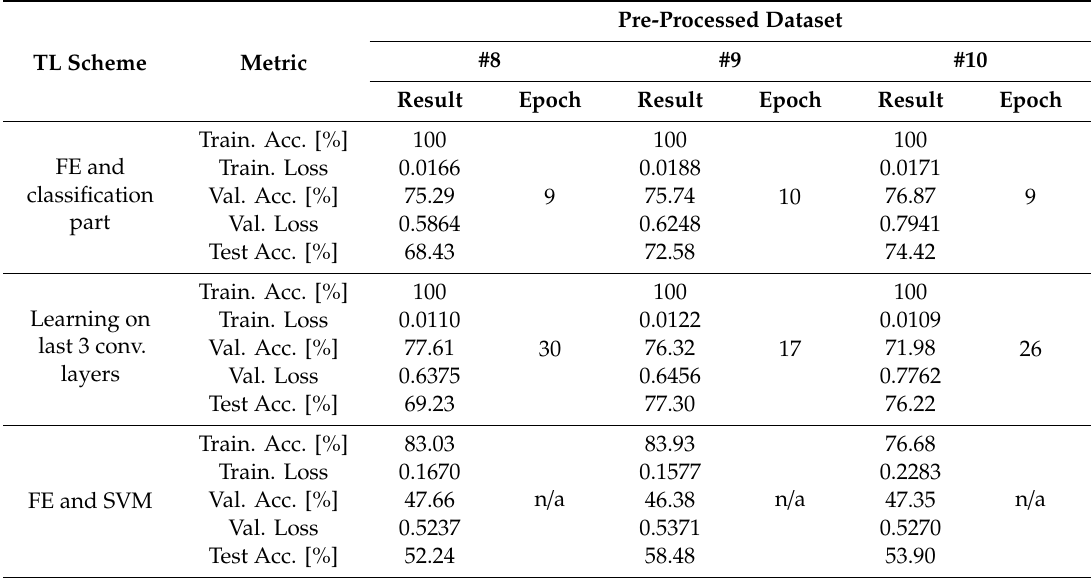
Table 6. Training, validation and test accuracy, and loss for di ff erent TL schemes on the AlexNet-based network (DRGV + 2018 pre-processed datasets).